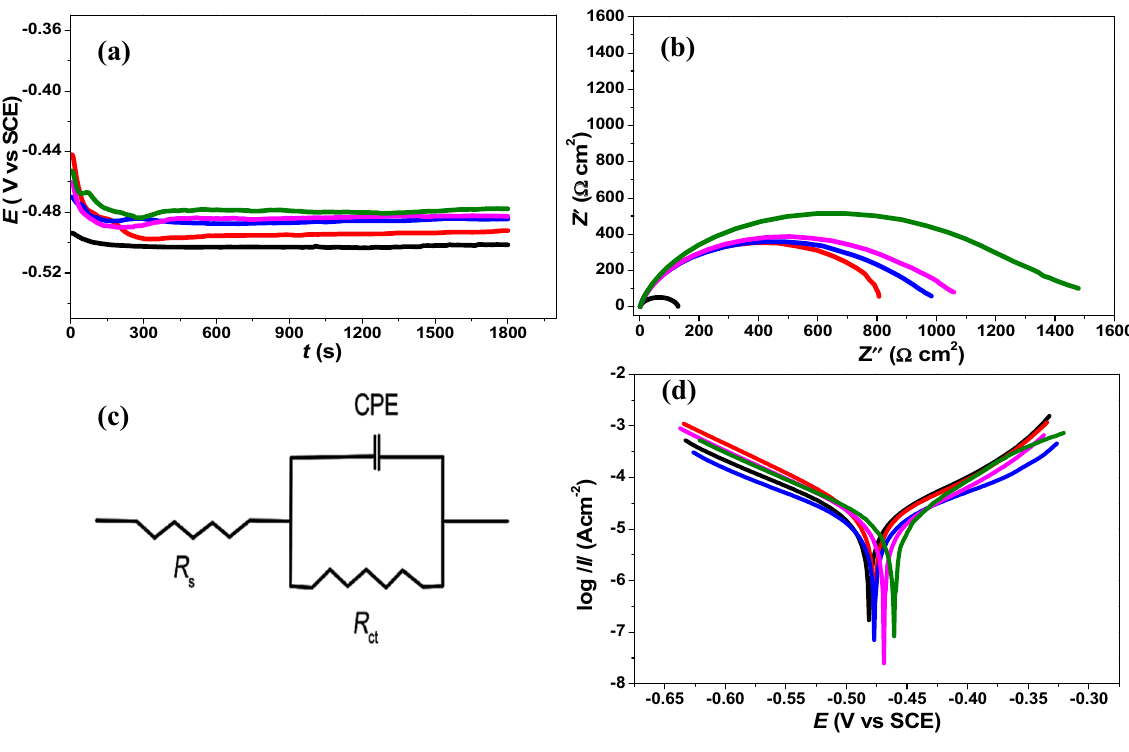
Key: Black = 1 M HCl; red = 500 mg/L Et-ACPE; blue = 100 mg/L Et- AgNPs; purple = 200 mg/L Et-AgNPs; green = 500 mg/L